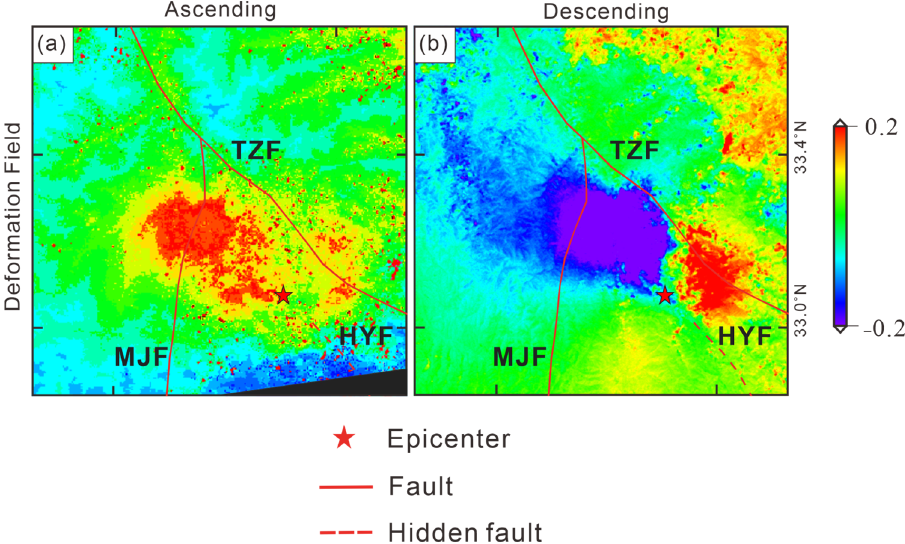
Figure 8. Displacement unwrapped from the interferogram image enhanced by SPF method. Panel ( a ) is the deformation field unwrapped from the interferogram in ascending orbit; ( b ) is the deformation field unwrapped from the interferogram in descending orbit.